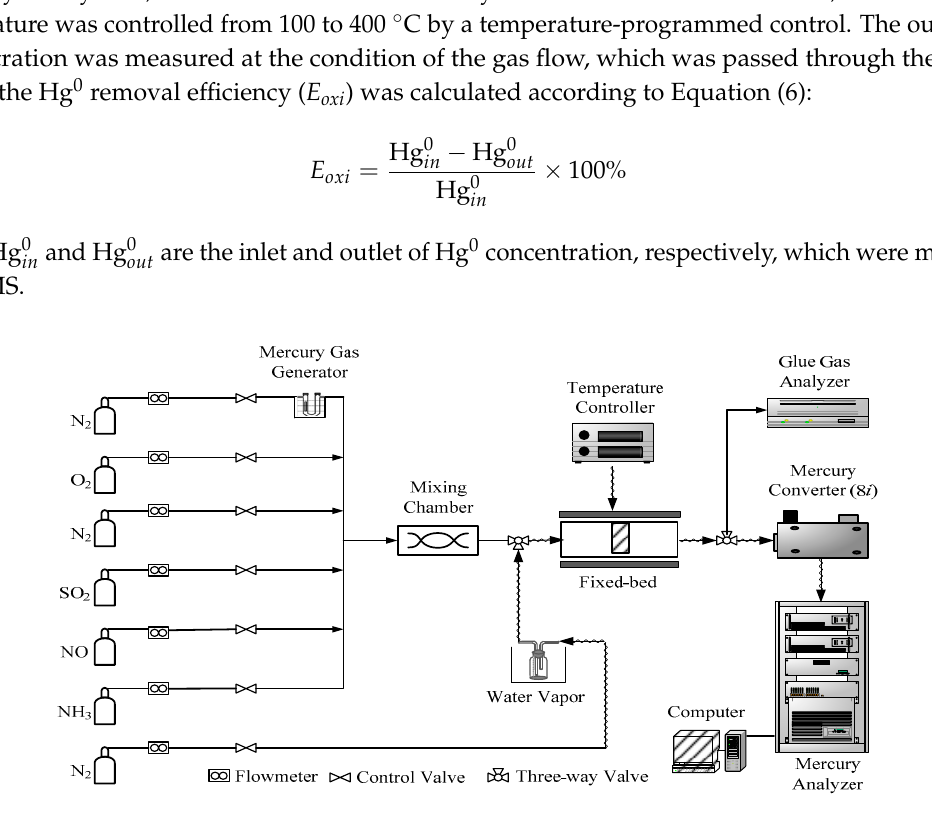
Figure 11. Schematic diagram of the experimental setup.